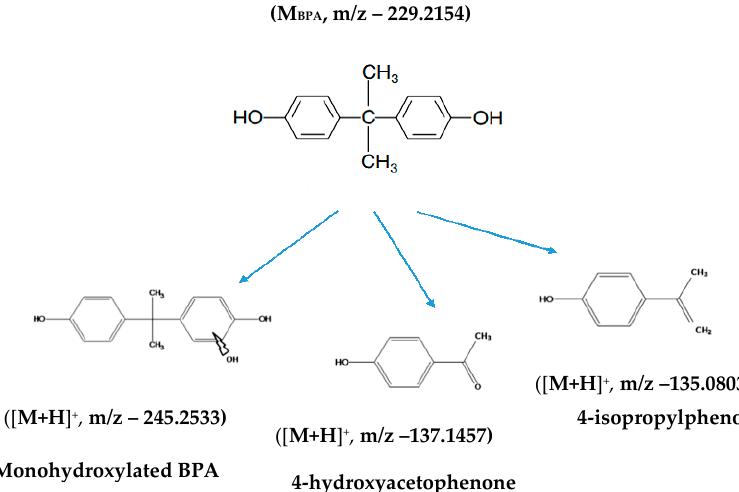
Figure 8. The decomposition products of bisphenol A.